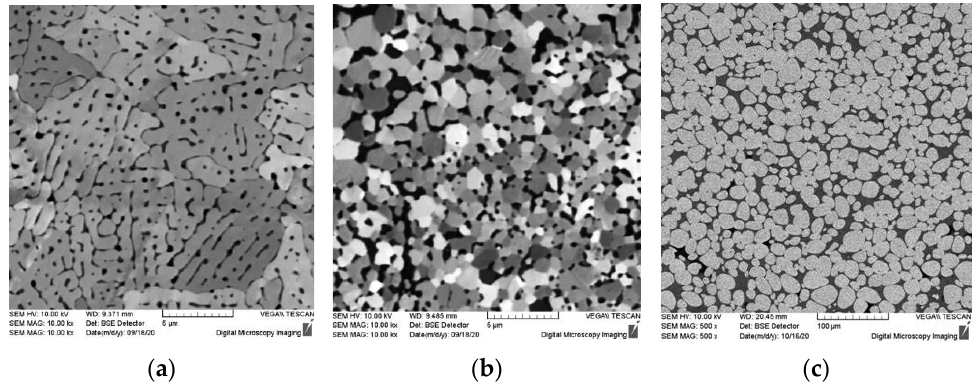
Figure 15. Microstructure of W-5Ni-2Fe samples produced by various technologies: SLM ( a ); SPS ( b ); LPSD ( c ).